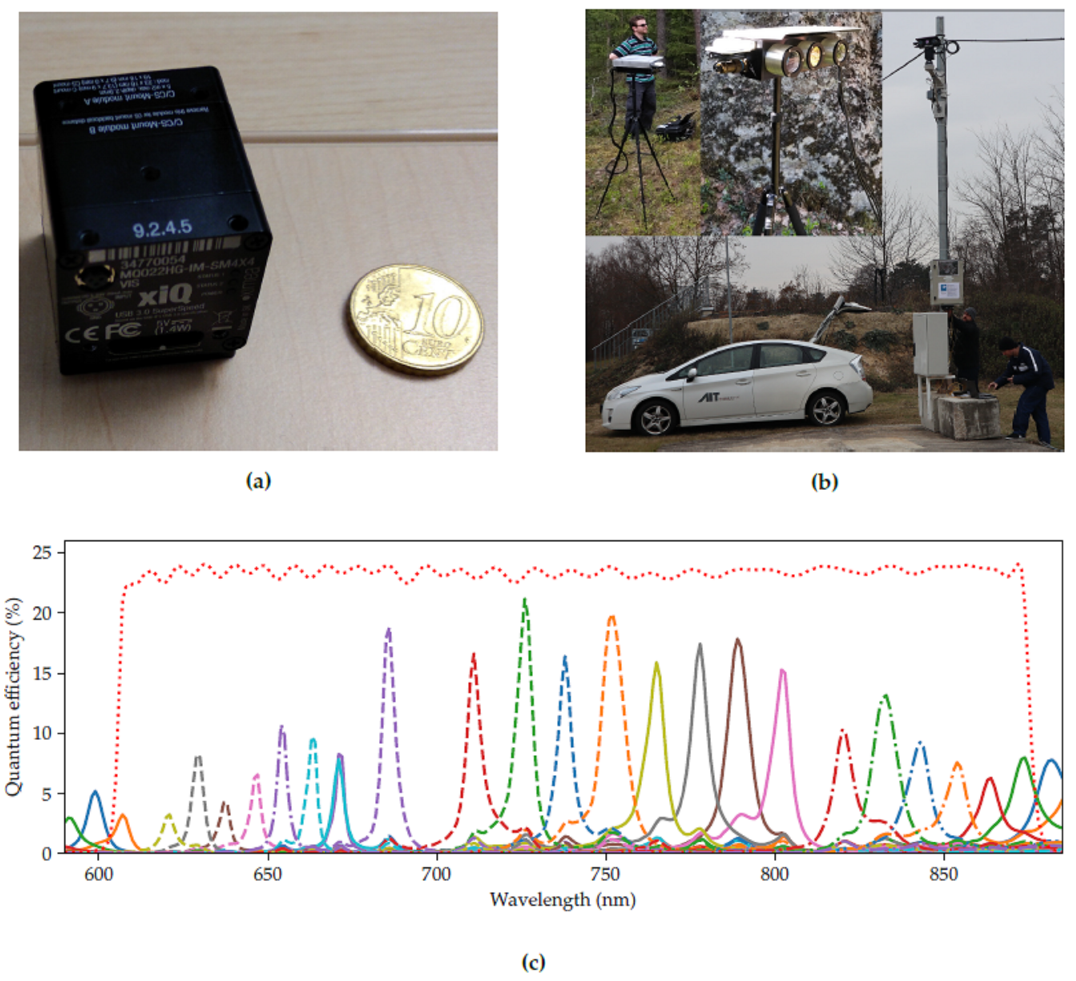
Figure 5. The camera system. ( a ) XIMEA MQ022HG-IM hyperspectral snapshot camera series compared to a 10 Euro Cent coin. ( b ) Camera system on a tripod (inlays, top-left), and on a mast equipped with a pan-tilt unit. ( c ) Response curves of the XIMEA MQ022HG-IM-SM5X5-NIR (Generation 1). The red dotted line is the combined transfer function of the optical